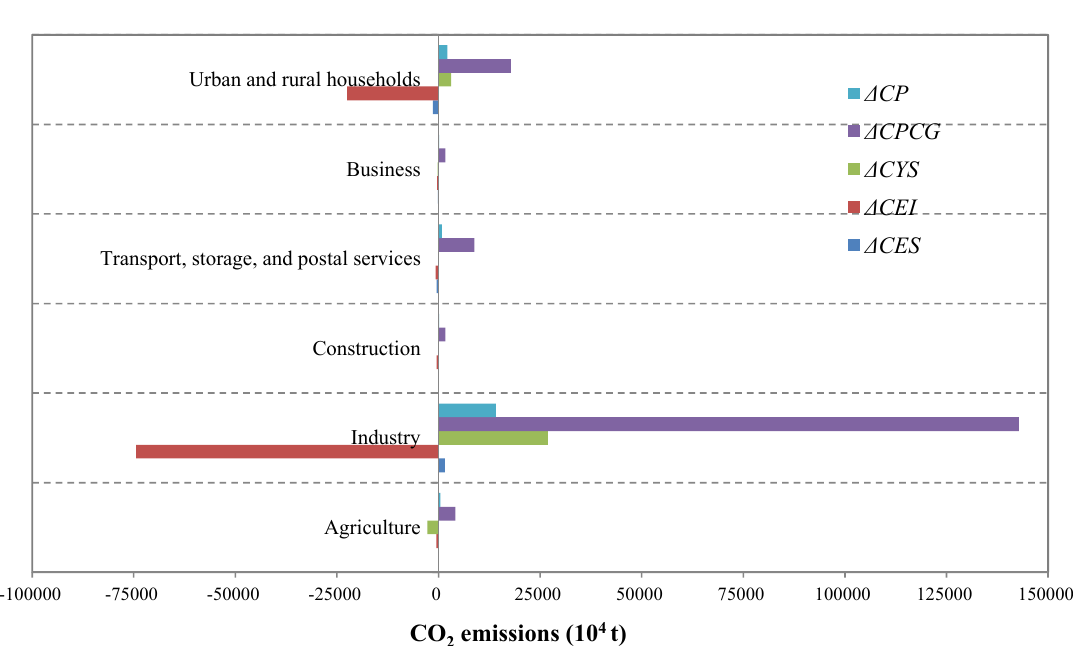
emissions in six 2